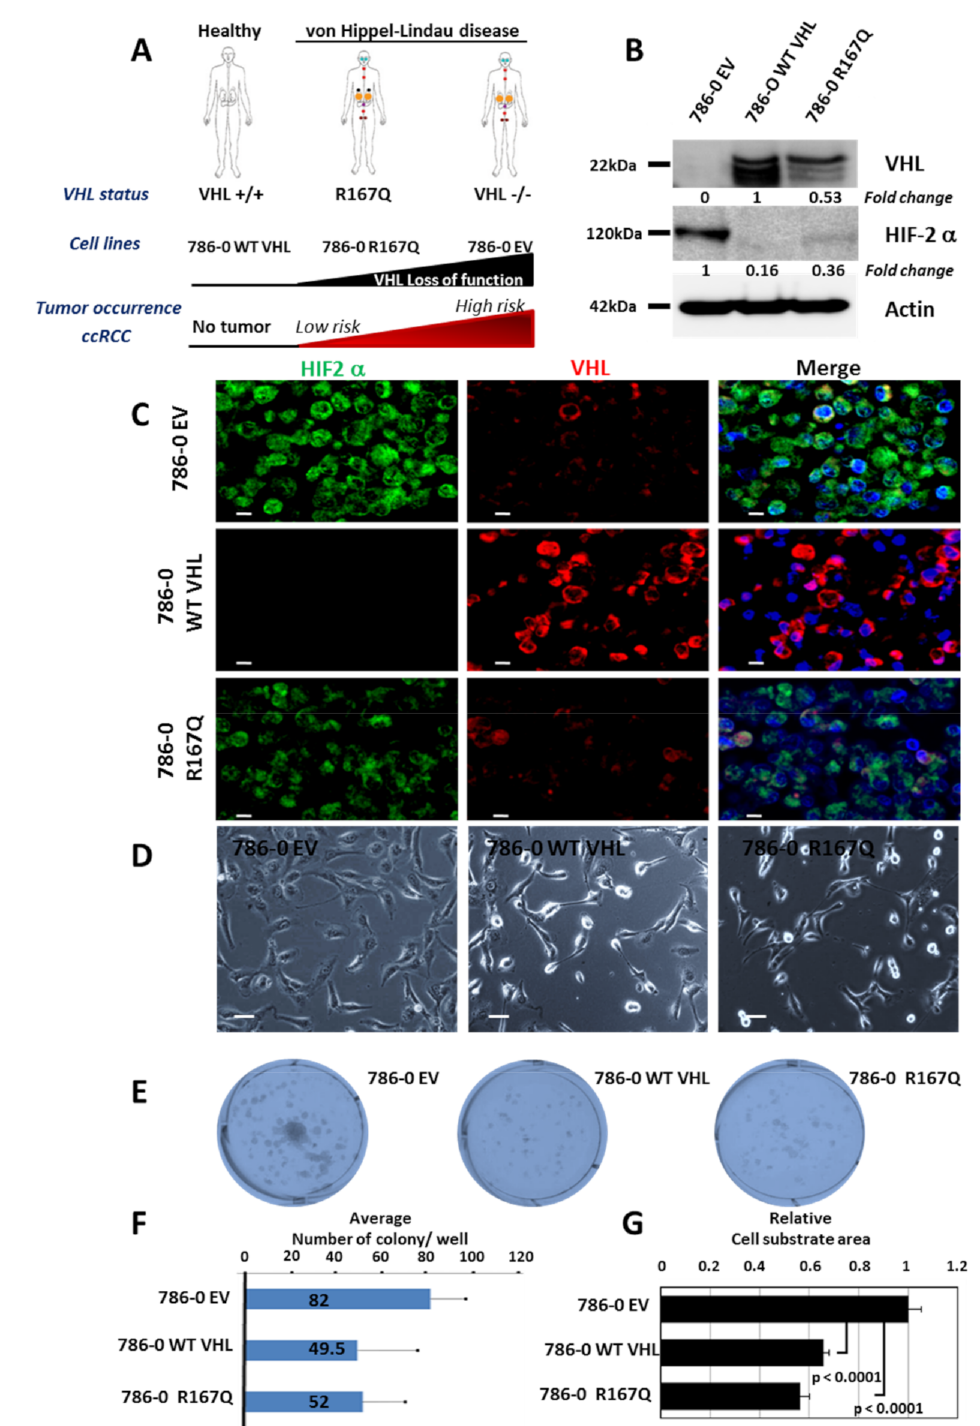
Figure 1. Similar cell morphology and colony formation for WT VHL and VHL-R167Q, whereas VHL-R167Q slightly promotes HIF-2 α . ( A ): Schematic representation of the 786-0 model and the consequences of VHL alterations on tumor occurrence (adapted from S. Couv é et al. [18]). VHL disease predisposes to ccRCC and pheochromocytomas (pheo) in patients, depending on the loss of function of VHL, with an ascending correlation. VHL disease is characterized by the development of tumors (circles): CNS hemangioblastomas that can occur anywhere along the brain–spine areas (red), retinal hemangioblastomas (blue), pheochromocytomas (black) and ccRCC (yellow) with a low (small circle) or high risk (large circle), pancreatic cysts and neuroendocrine tumors